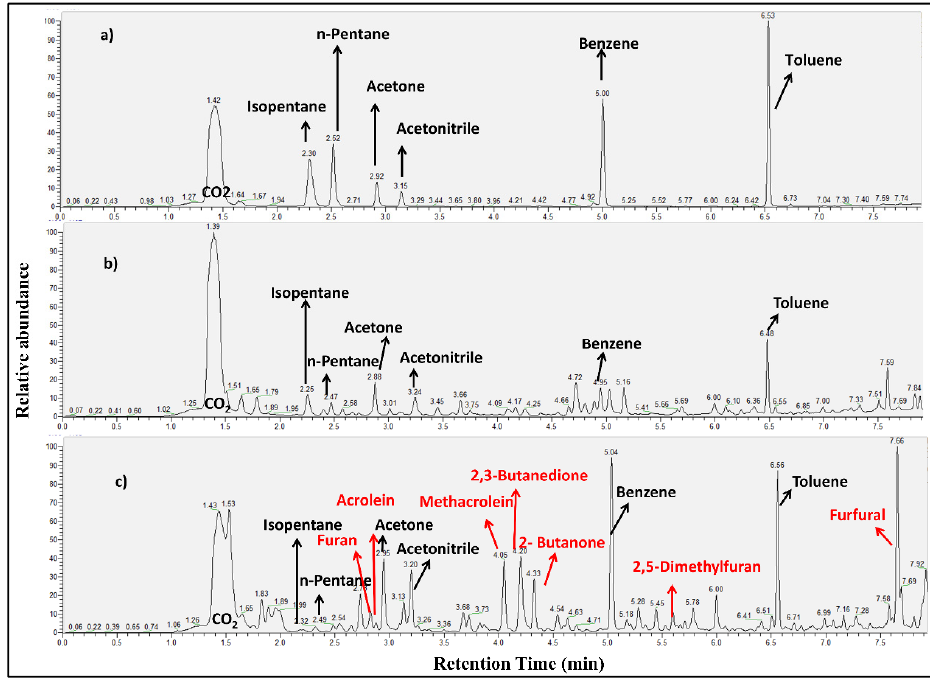
Figure 2. Chromatogram obtained using TD-GC-MS from the dual-bed samples collected from ( a )